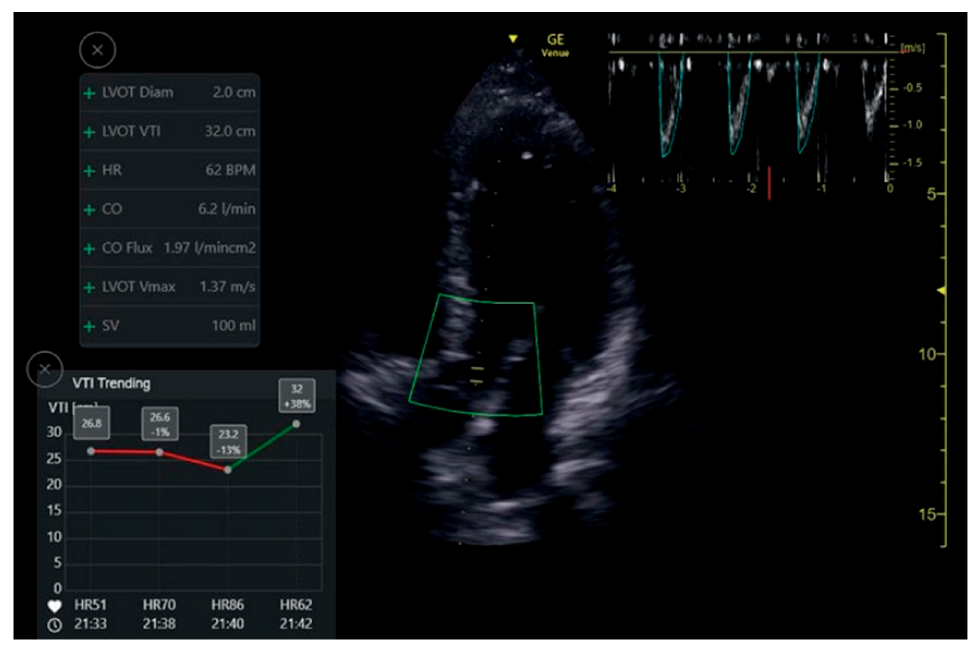
Figure 5. Auto VTI tool. When in Apical5Chamber-View. Auto marker placement, velocity pattern measurements and data display.